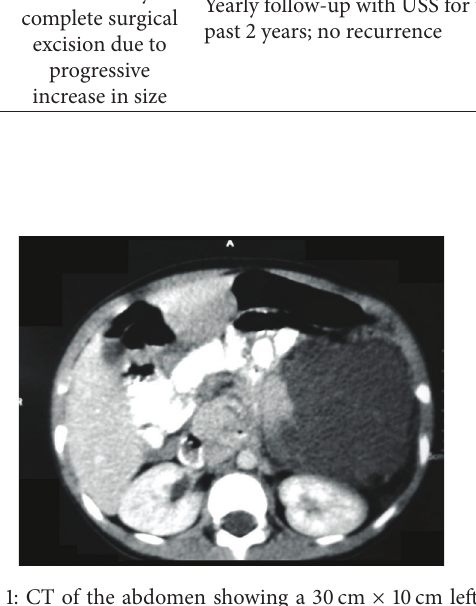
Figure 1: CT of the abdomen showing a 30cm × 10cm left sided isodense retroperitoneal